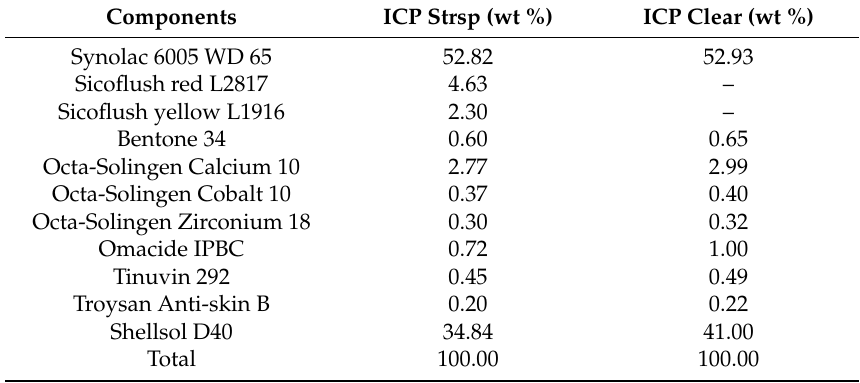
Table 2. Description of the solventborne Internal Comparison Product (ICP) in its semi-transparent (ICP strsp) and clear (ICP clear)